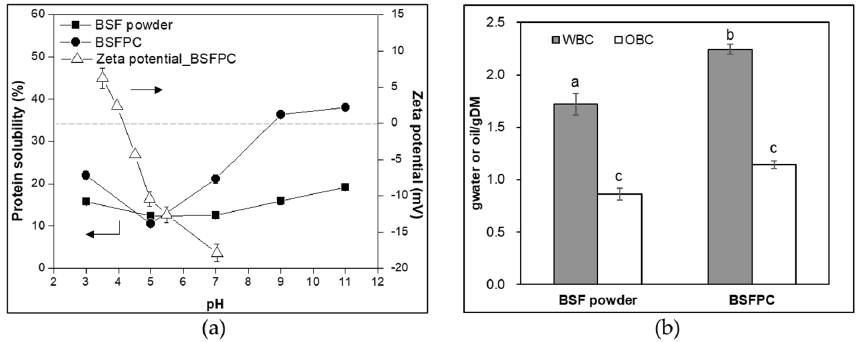
Figure 3. ( a ) Protein solubility at pH ranging from 3 to 11 and zeta potential at pH ranging from 3.5 to 7; ( b ) WBC (water binding capacity) and OBC (oil binding capacity) of BSF (black soldier fly) powder and BSFPC (black soldier fly protein concentrate). Different lowercase letters indicate sig- nificant differences at the p < 0.05 level.